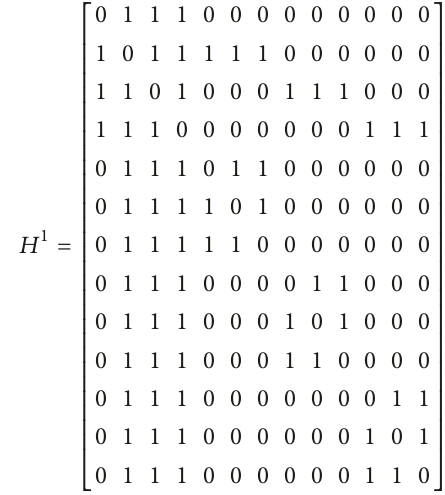
is to obtain the adjacency matrices. The element of adjacency matrix was the numbers of directed segment between two nodes (e.g., if there were one directed segment from “Tang dynasty” to “Invention,” the element is